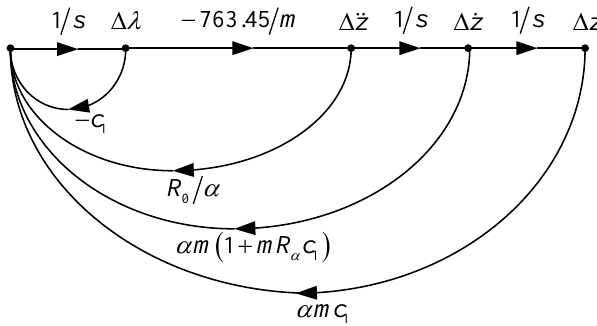
z ∆ Figure 3. Signal-flow diagram of the (PBC) system.